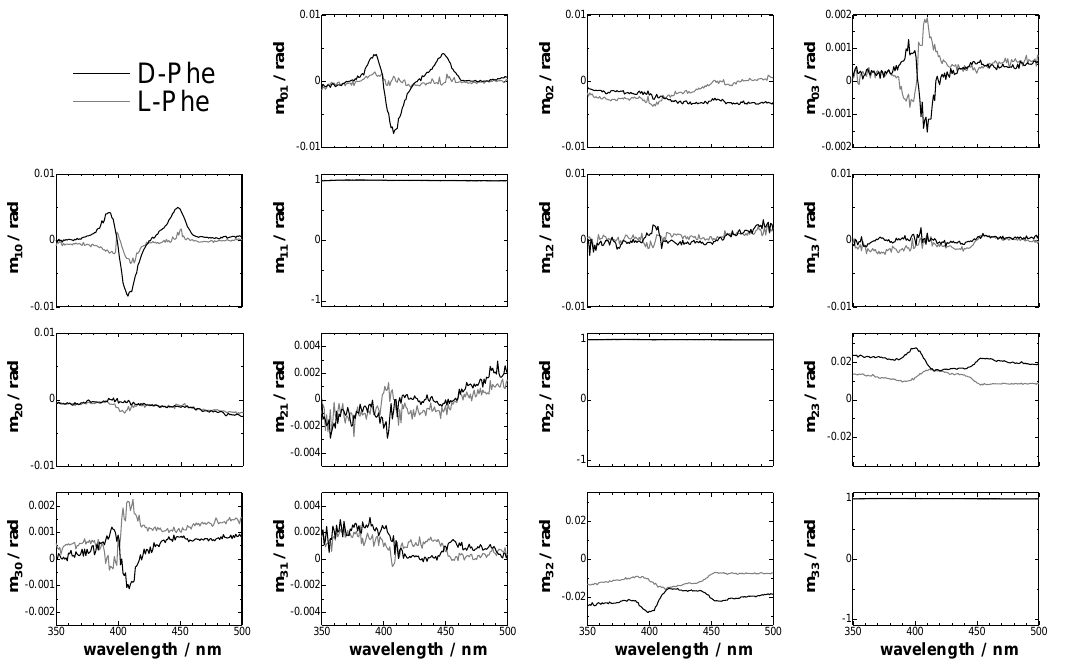
Figure 4. Detail of the experimental normalized Mueller matrices of TPyP-CuTPPS hetero-aggregates in the toluene-water system. [TPyP] [CuTPPS] = 1.6 × 10 −4 M, [Phe] aq 2.3, toluene:chloroform = 96:4, v/v, t = 30 min.